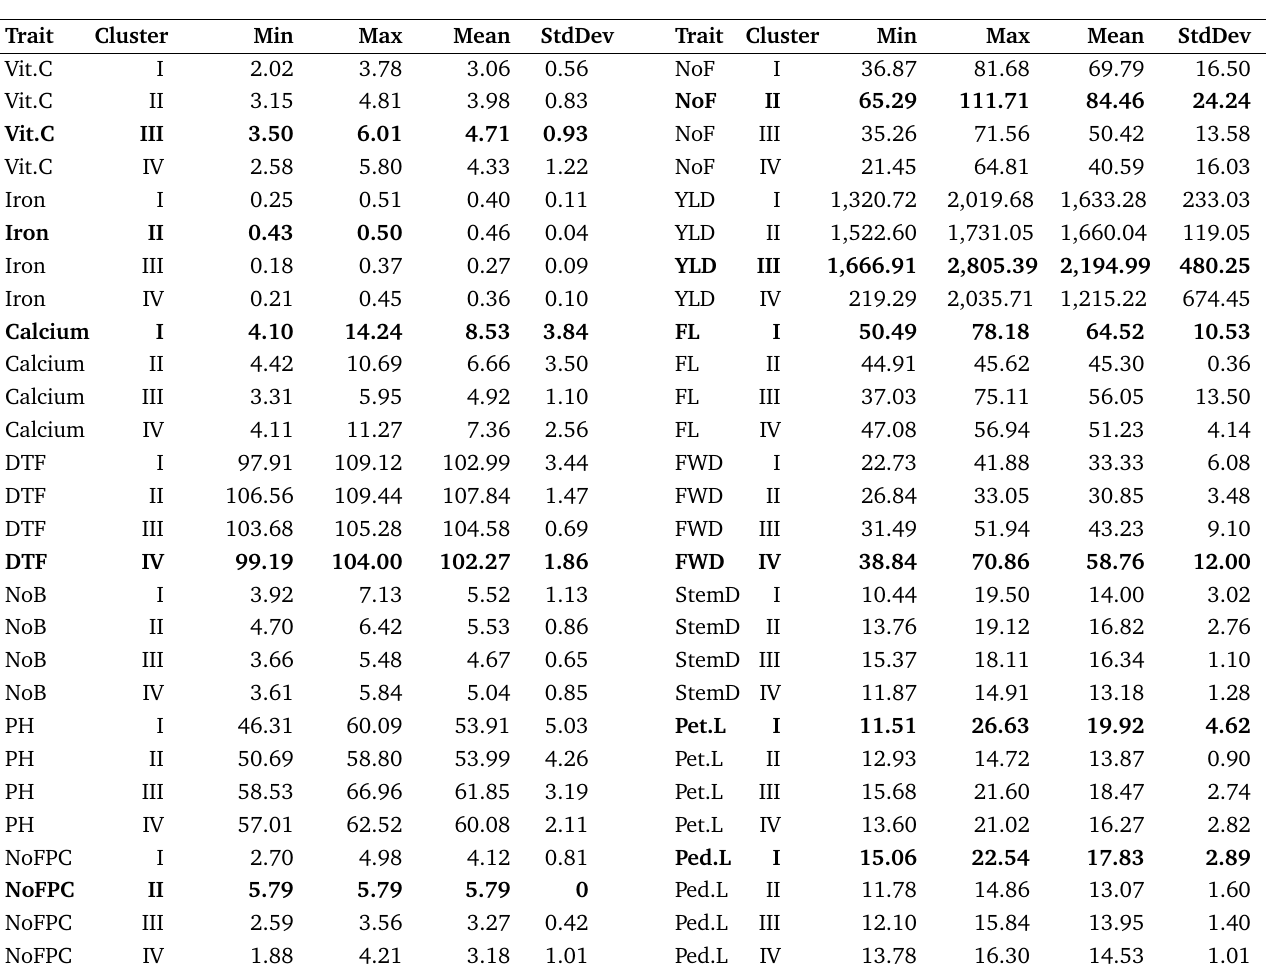
Table 6. Means and standard deviations for various traits in different clusters. The clusters with the highest values for each trait are highlighted in bold font. DTF, days to flowering; NoB, number of branches; PH, plant height at maturity; NoFPC, average number of fruits per cluster; NoF, average number of fruits per plant; YLD, average yield per plant; FL, fruit length; FWD, fruit width; StemD, stem diameter; Pet.L, petiole length; Ped.L, pedicel